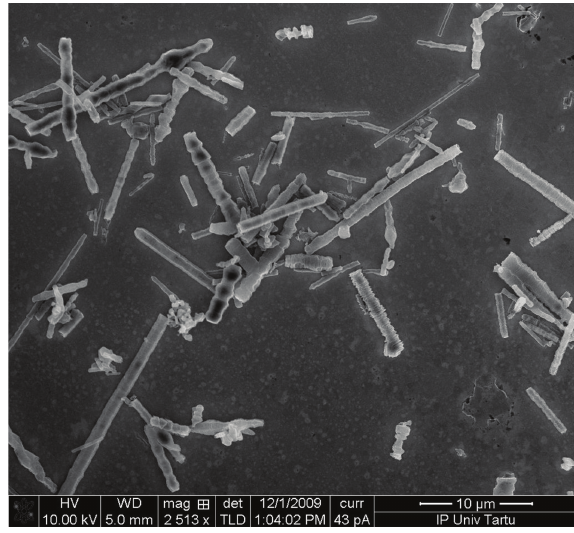
Figure 3: Closer SEM image of the SCNRs (cid:4)(cid:4) , magnified 32479x.